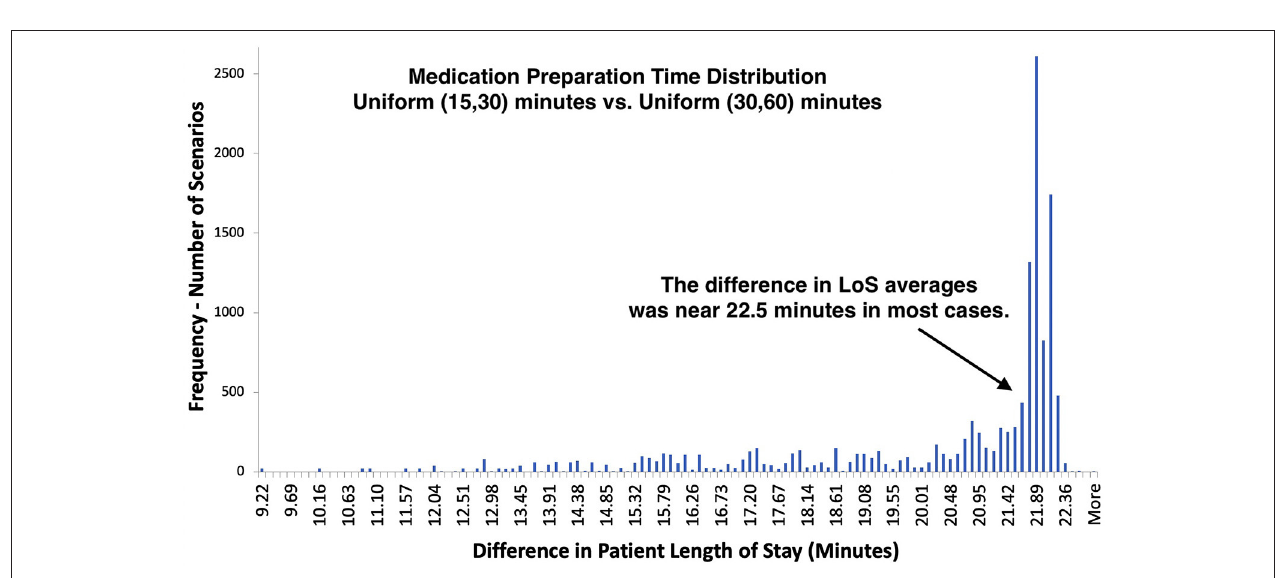
FIGURE 5 | Distribution of LoS difference under different medication preparation times – comparison of 13,500 walk-in scenarios with 60min infusion